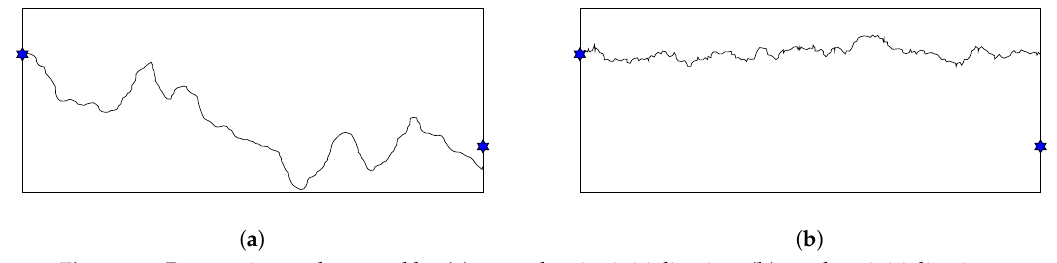
Figure 12. Penetration path created by ( a ) control-point initialization; ( b ) random